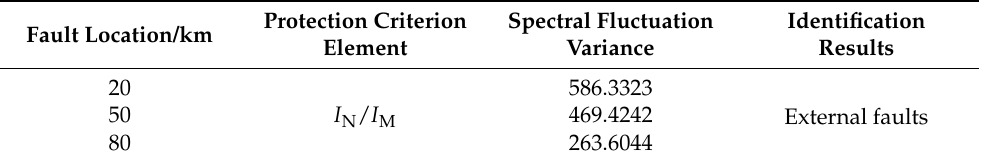
Table 2. Spectrum fluctuation variance in fault current ratios at different fault locations during the external A-phase ground